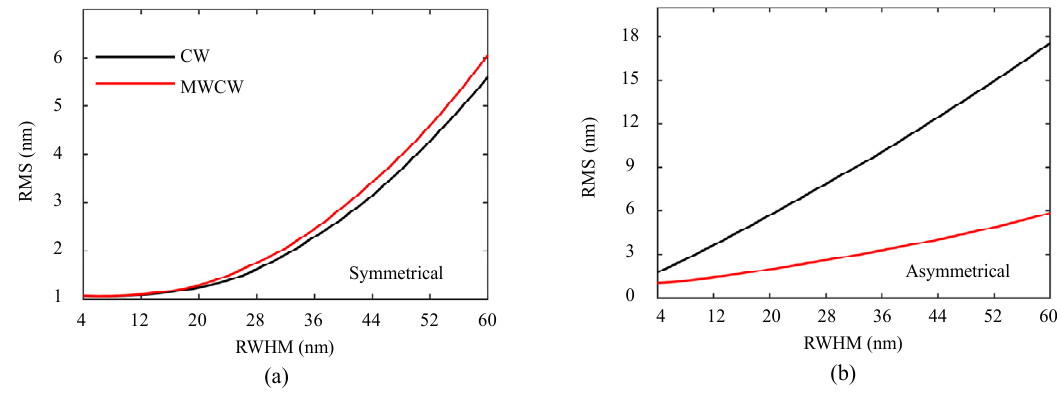
Fig. 8 Impact of bandwidth on performance of two methods when used for (a) symmetrical and (b) asymmetrical S ( 